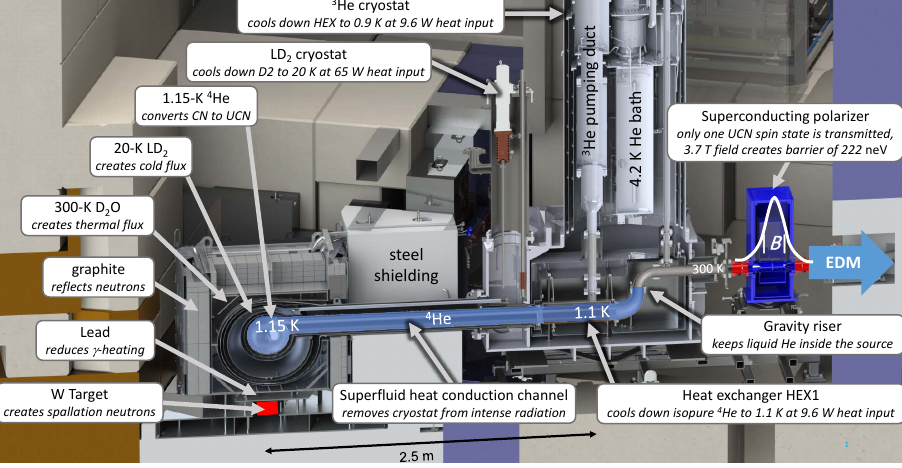
Figure 1. Cutaway view of the 3D model for the TUCAN